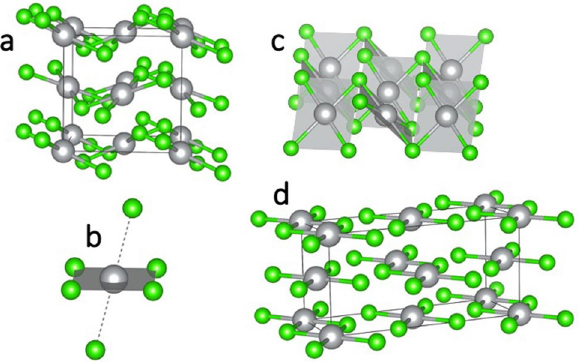
Figure 5. Structural features of AgF 2 -type polymorph: (a) ambient-pressure structure; (b) local coordination of Ag in the ambient-pressure structure; (c) one layer at 40 GPa in HSE06 approach—note that axial Cl atoms are now within the same layer, a pair of those contacts is marked with red dashed line; (d) structure resulting from phase transition between 40 and 50 GPa (30 and 40 GPa in PBEsol + U approach). Note the CuCl 2 -like chains. Ag—grey, Cl—green.